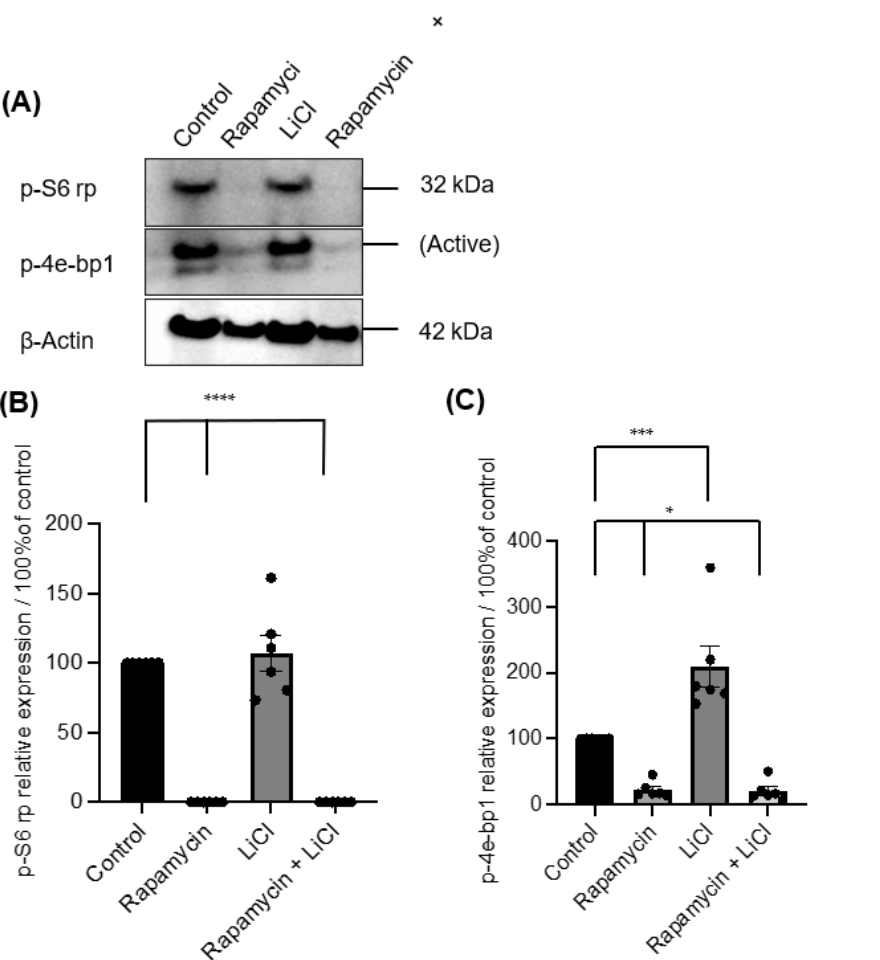
Figure 3. ( A ) Immunoblotting of p-S6 rp and p-4e-bp1 in untreated (control) and salispheres treated with rapamycin, LiCl, and the combination of rapamycin and LiCl (rapamycin + LiCl). ( B ). Rapamycin alone or combined with LiCl completely abolished the expression of p-S6 rp (**** p < 0.0001), but LiCl only did not affect the expression of p-S6 rp ( p = 0.8898). ( C ) A considerable reduction in the phosphorylation of 4e-bp1 was observed in salispheres treated with rapamycin alone and co-treated with rapamycin and LiCl (* p < 0.05). In contrast, a significant increase in the phosphorylation of 4e-bp1 was detected in LiCl-treated salispheres (*** p = 0.0006). The bar represents the mean ± S.E.M ( n = 6).